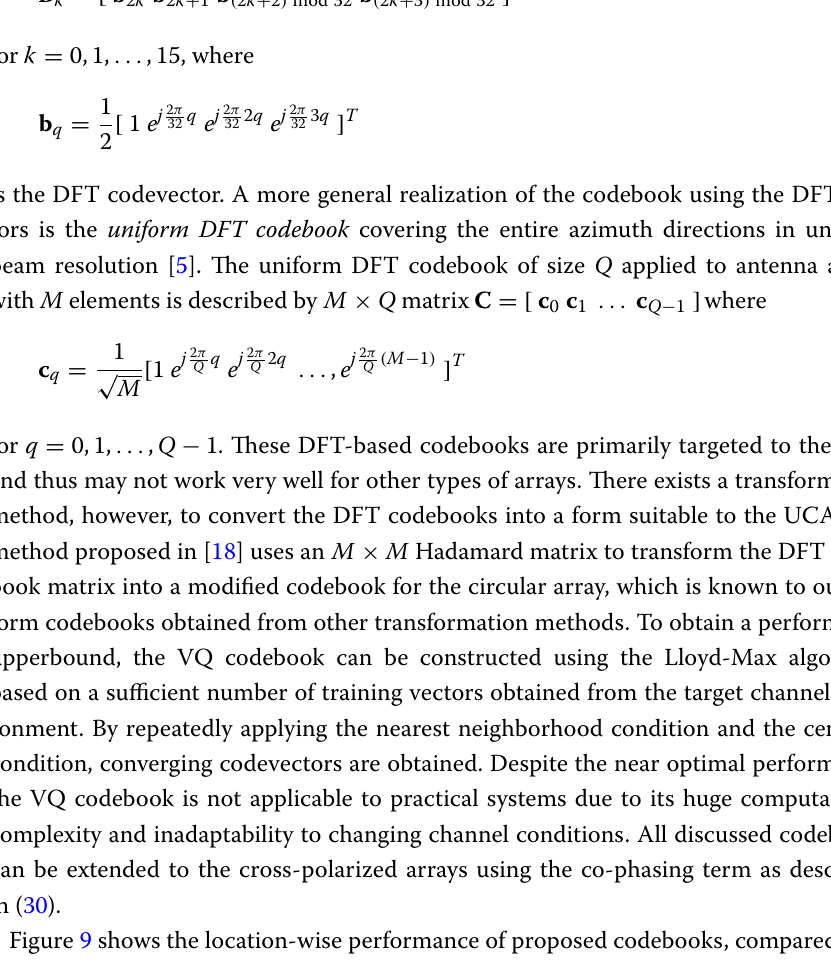
Fig. 9 Location-specific performance of codebooks using B